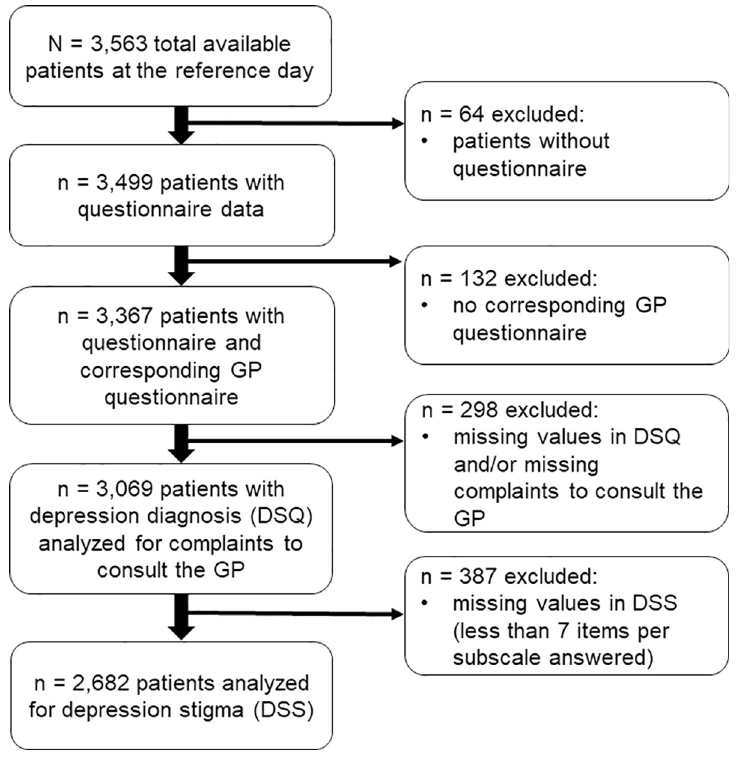
Fig 1. Flow chart of sampling